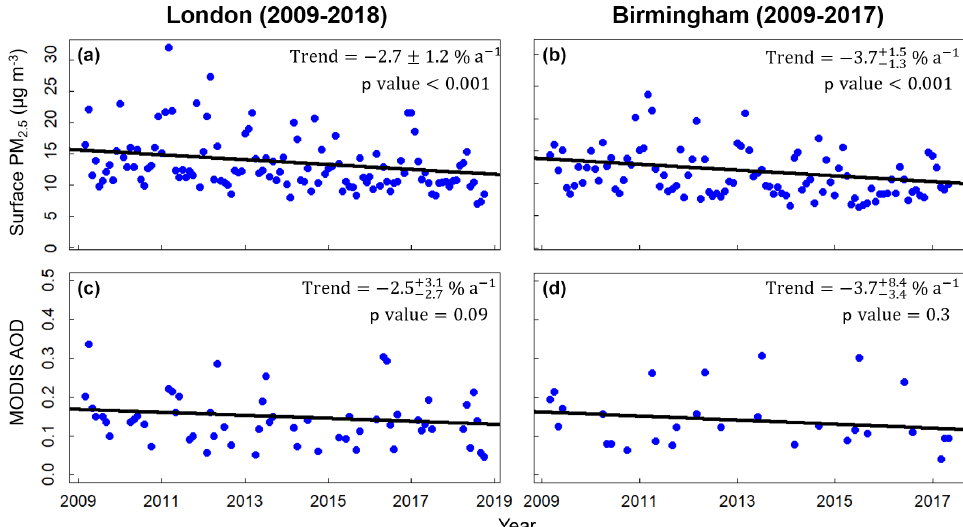
Figure 5. Time series of surface PM 2 . 5 and MODIS AOD in 2009–2018 for London (a, c) and 2009–2017 for Birmingham (b, d) . Points are city-average monthly means of PM 2 . 5 from the surface network (a, b) and AOD from MODIS (c, d) . Black lines are trends obtained with the Theil–Sen single median estimator. Values inset are annual trends and p values. Absolute errors on the trends are the 95% CI. Trends are considered significant at the 95% CI ( p value < 0.05).